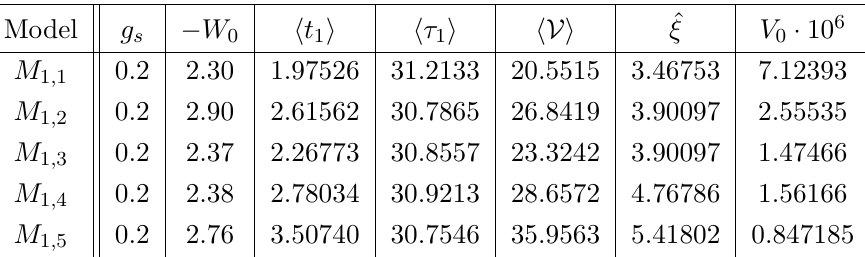
Table 10 . For all CICYs with h 1 , 1 = 1 , we present the α 0 -uplifted stable dS vacua lying in a relatively lower volume regime. The underlying parameters are set as a the axion ρ is minimized at h ρ 1